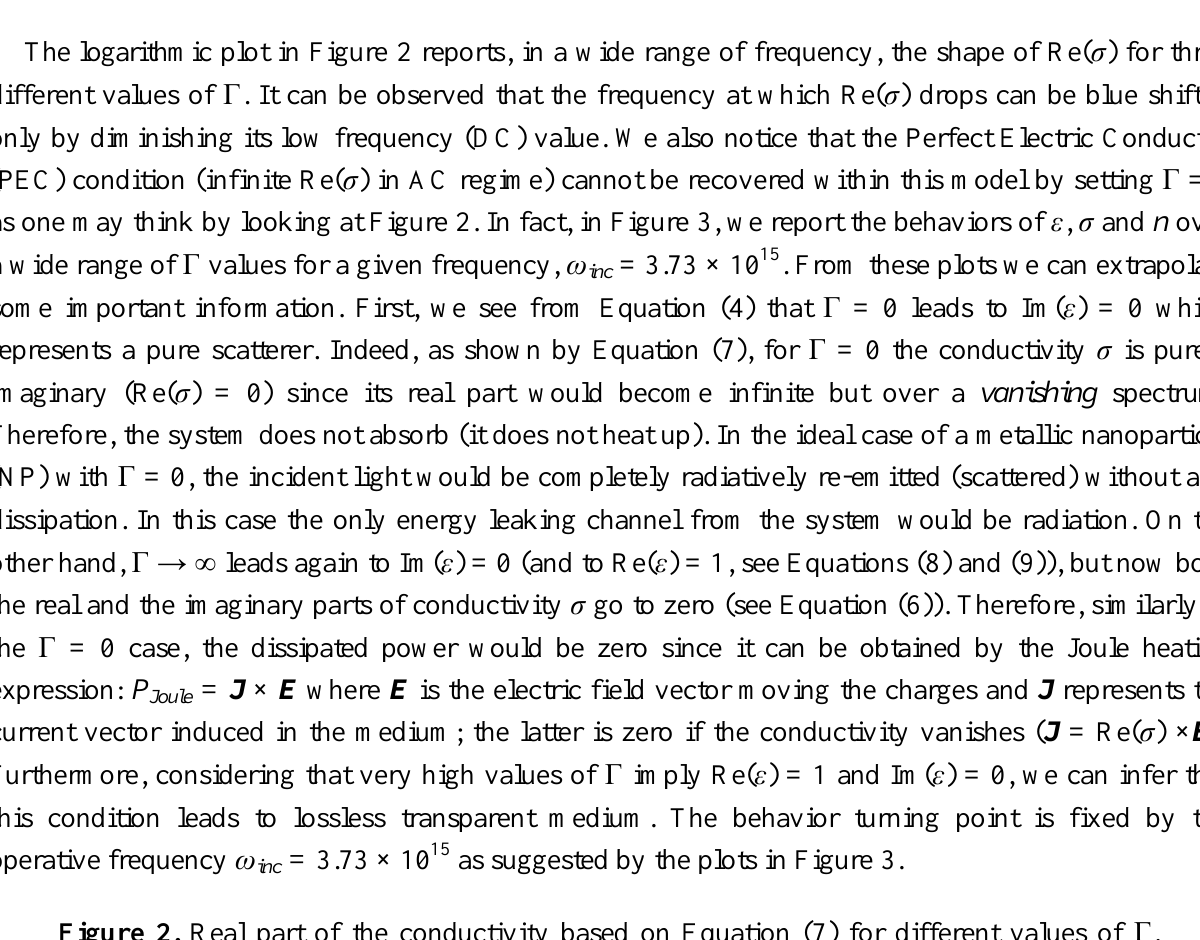
Figure 2. Real part of the conductivity based on Equation (7) for different values of Γ. Both axes are in logarithmic